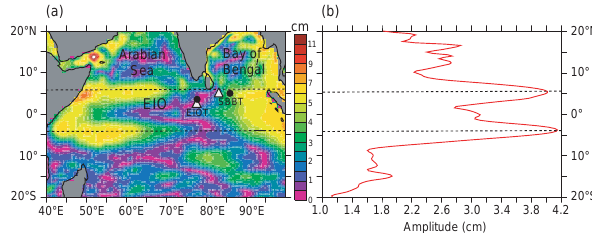
Fig. 1. (a) Spatial distribution of semi-annual amplitude of SSHA (cm) and (b) zonal distribution of meridionally averaged semi- annual amplitude of SSHA (cm) in the Indian Ocean. Broken line defines the boundary of equatorial Indian Ocean (EIO) (see text for details). Filled black circles represent the sediment trap loca- tion SBBT and EIOT and filled white triangles represent the in-situ observation on board ORV Sagar Kanya during August